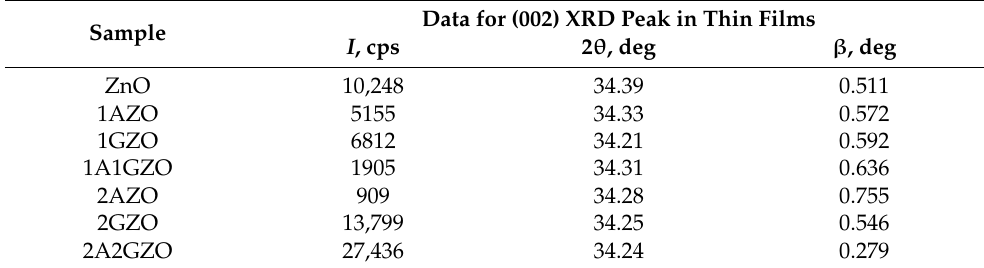
Figure 3. XRD spectra of pure ZnO, single-doped (1AZO, 2AZO, 1GZO, and 2GZO) and co-doped (1A1GZO and 2A2GZO) thin films deposited at substrate temperature 300 °C. Table 2. XRD data for intensity I , angular position 2 θ , and integral breadth β of (002) ZnO peak for the thin films deposited at 300 °C.